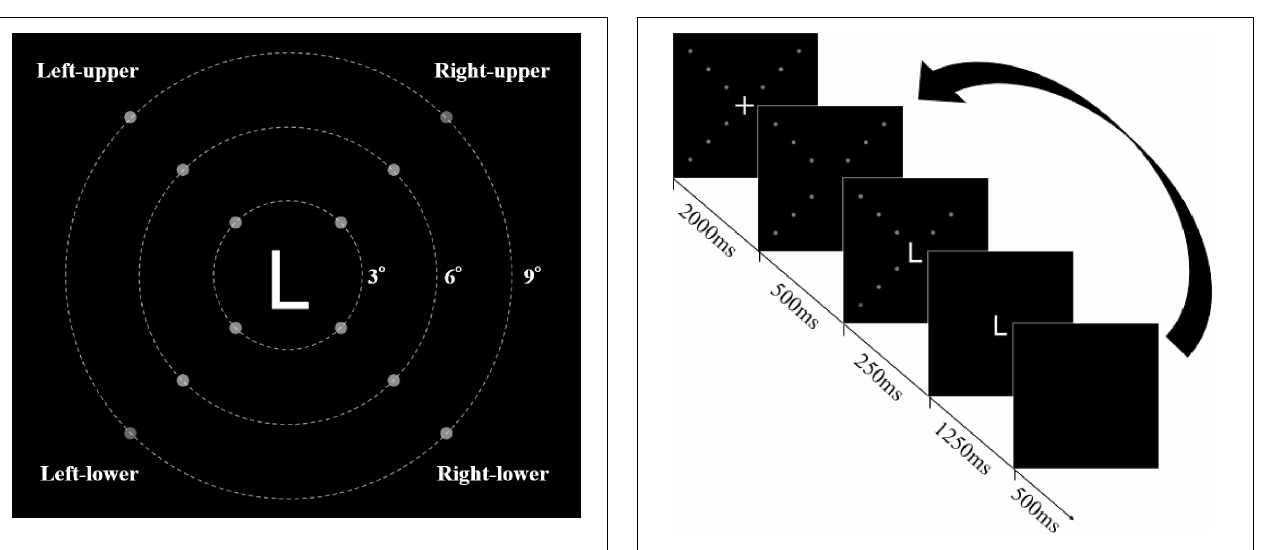
88 cd/m 2 ) was presented in the center of the screen, and a total of 12 dots were presented in the peripheral field of view. The dots were 0.55 ◦ in diameter at a visual angle and allocated on three concentric circles (eccentricity: 3 ◦ , 6 ◦ , and 9 ◦ in diameter). Each of the four dots in the circle was 90 ◦ apart and 45 ◦ from the horizontal-vertical direction.